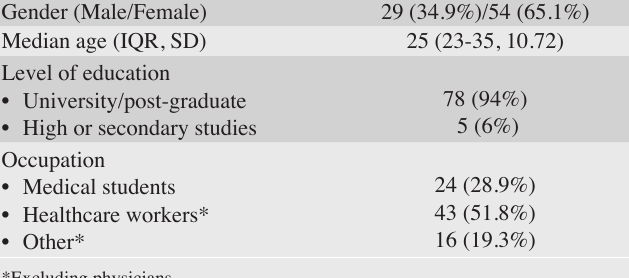
Table 1. Characteristics of the